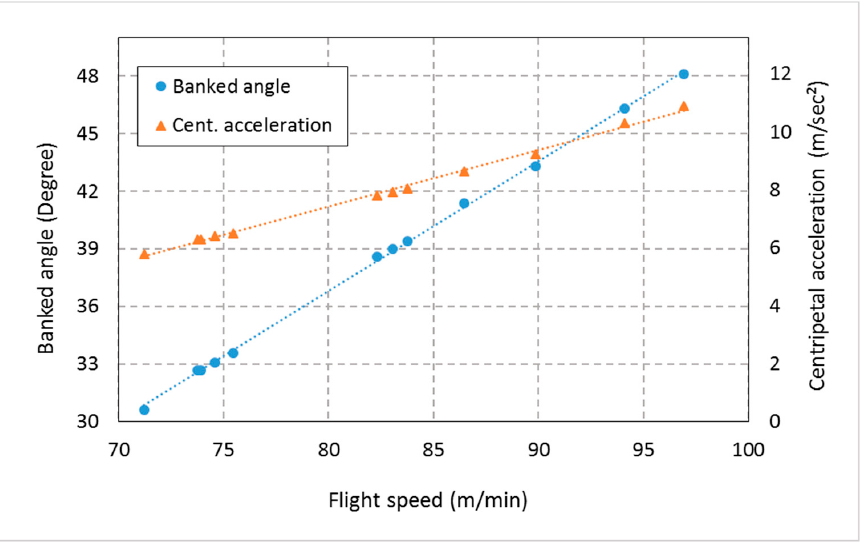
Figure 23. Flight speed versus calculated banked angle and centripetal acceleration of ten weevils, measured at suspension angle of 40° under a controlled atmosphere with temperatures of 30 °C and RH of 35%.